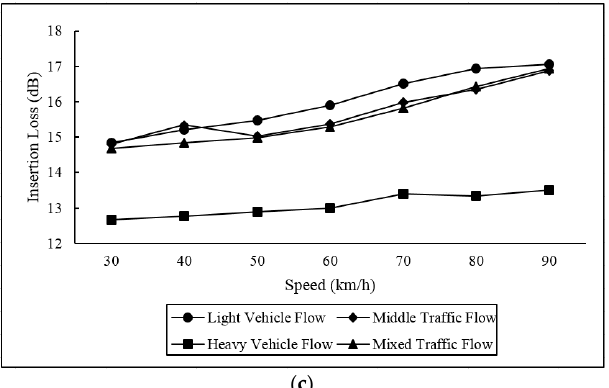
Figure 8. Insertion loss of barrier with different flow speeds. ( a ) Point R1; ( b ) Point R2; ( c ) Point R3.